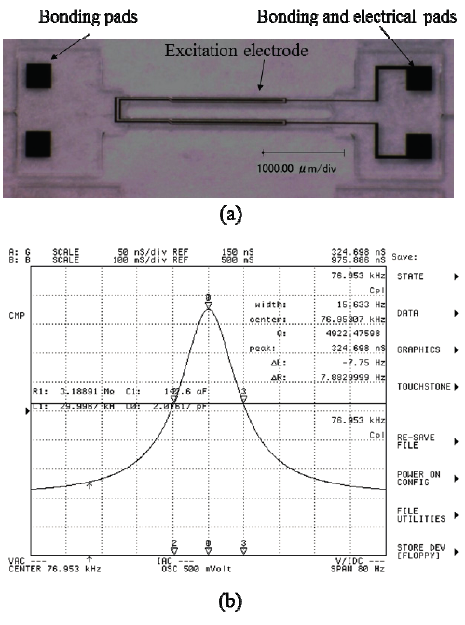
Figure 6. Fabricated DETF: ( a ) Optical view; ( b ) Measured vibration characteristics.